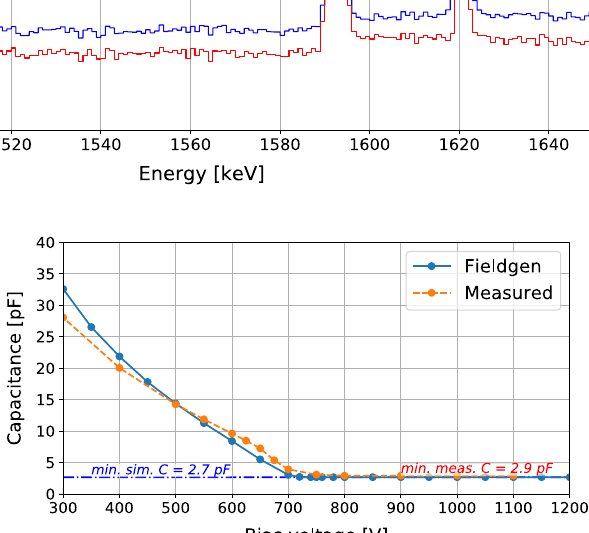
Fig. 23 Close-up of the 228 Th (ANN trained on real pulses, MC data classified) spectrum before and after the cut rejecting MSEs (the same spectrum as in the bottom panel of Fig. 21), showing the effect of the PSA method on peaks consisting of events of different types.